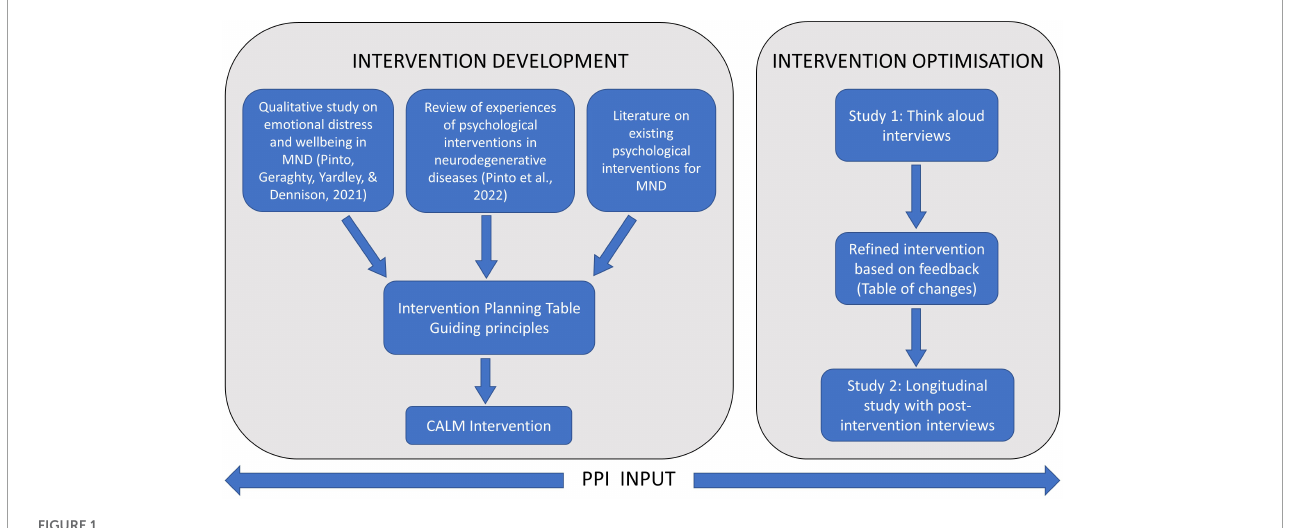
FIGURE1 Process of intervention development and optimisation.